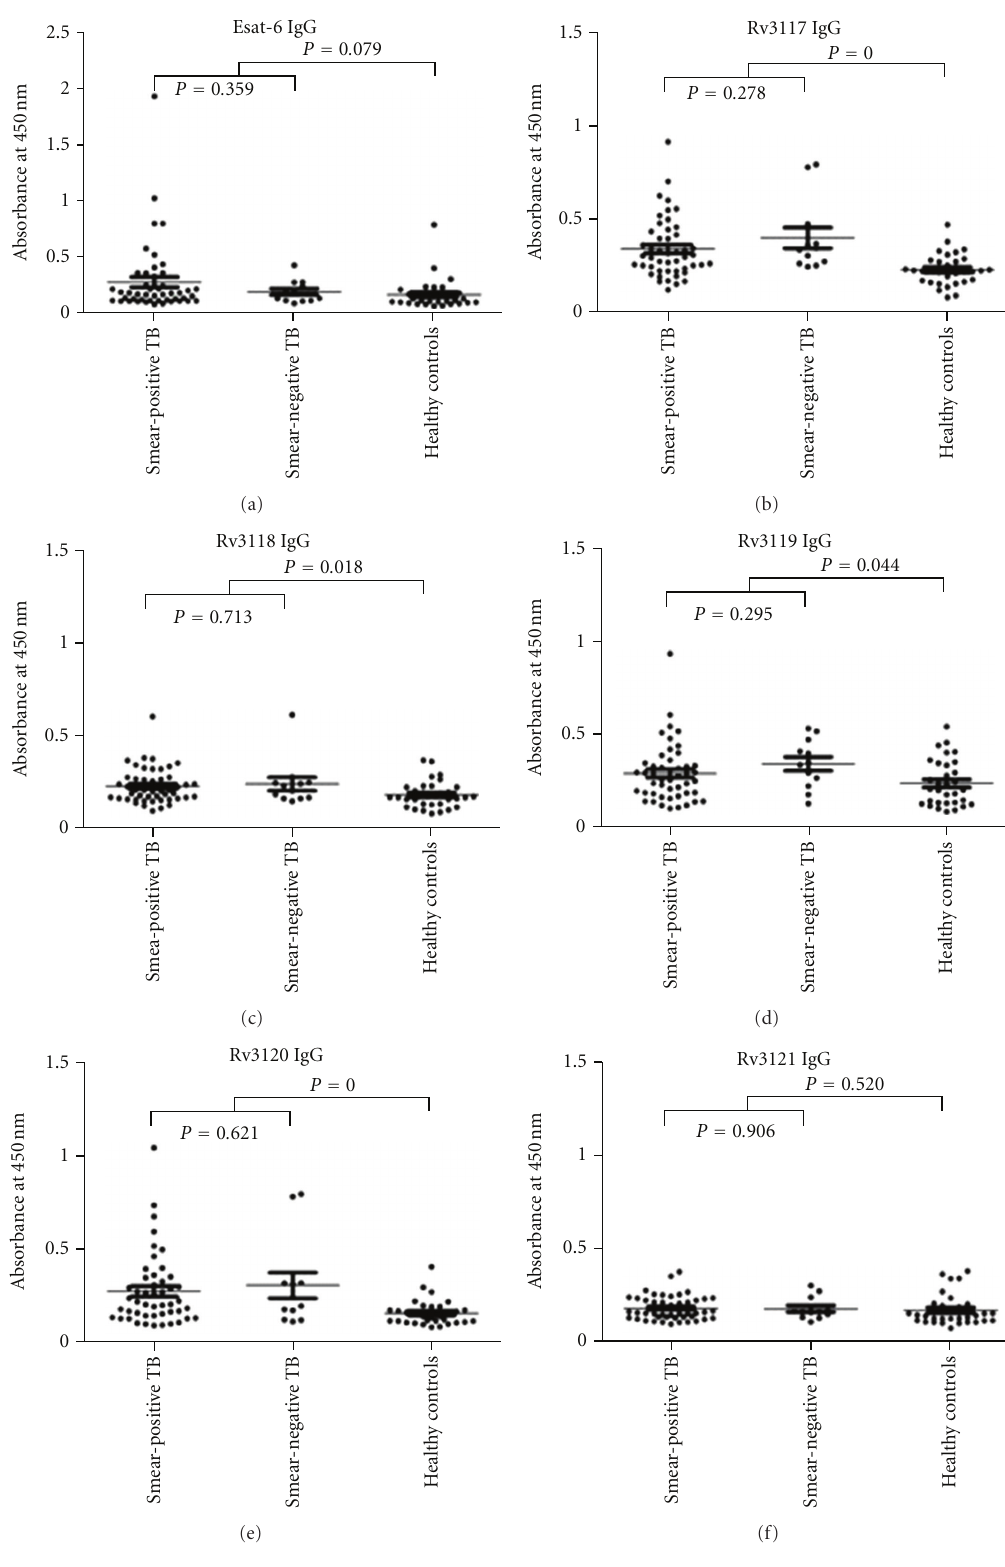
Figure 2: The humoral immune responses directed against the EAST-6 antigen (a) and Rv3117–Rv3121 recombinant proteins ((b)–(f)) were compared among di ff erent categories of patients and healthy controls. Horizontal lines indicate the means and the standard error of the mean of absorbent value each group. P values are shown above the plots determined by two-tailed one-way ANOVA and independent-samples t